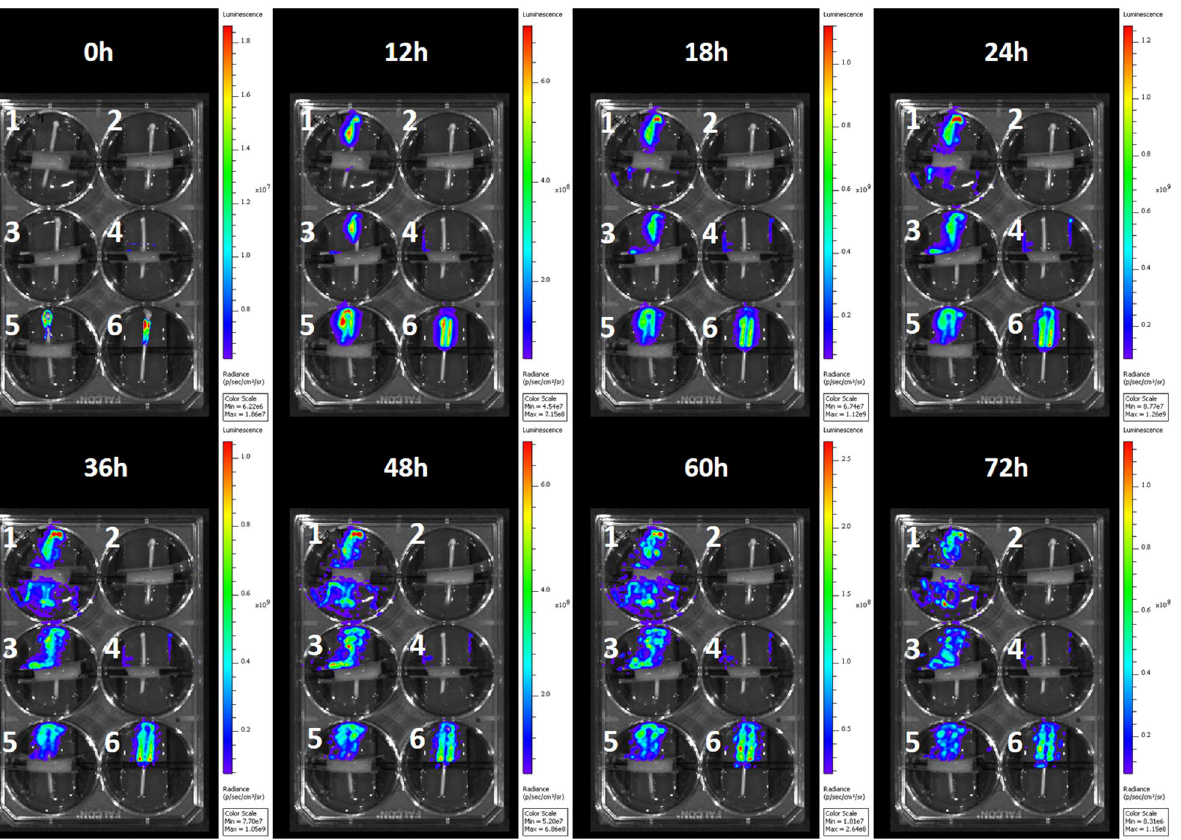
Figure 4. IVIS images of bioluminescent E. coli XEN14 on ex vivo model at time at 0, 12, 18, 24, 36, 48, 60, and 72 h post-inoculation. Real-time video (Video S1) showed migration path through the skin-catheter interface. Interventions: (1) Unmodified catheter with skin, (2) No inoculation with skin, (3) Non-eluting catheter with skin, (4) Eluting catheter with skin, (5) Antibiotic Control, (6) Unmodified catheter without